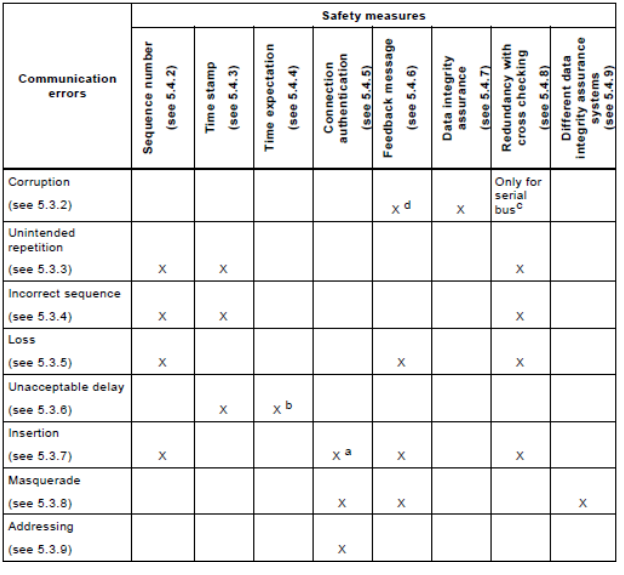
Fig. 6. Overview of the effectiveness of the various measures on the possible errors Even when the messages are arriving in a correct (deterministic) manner the safety data still may be corrupted.